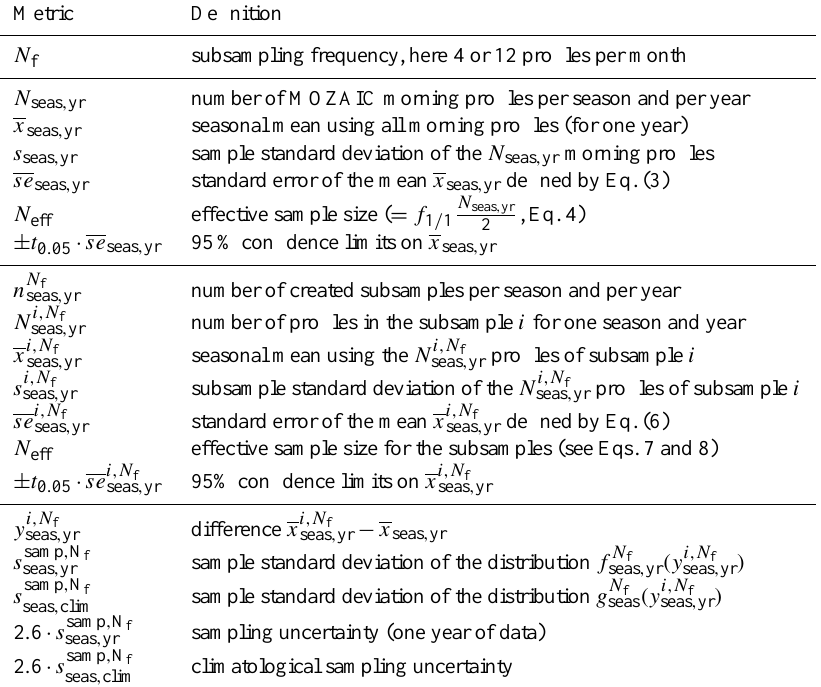
Table 2. List of the metrics used and their definition. t 0 . 05 is the 95th percentile of the Student’s t-distribution with N eff − 1 degrees of freedom. N eff is defined in Eq. (4) for the morning data set and in Eqs. (7) and (8) for the subsamples. Metric Definition N f subsampling frequency, here 4 or 12 profiles per month N seas , yr number of MOZAIC morning profiles per season and per year seasonal mean using all morning profiles (for one year) sample standard deviation of the N seas , yr morning profiles standard error of the mean x seas , yr defined by Eq. (3)